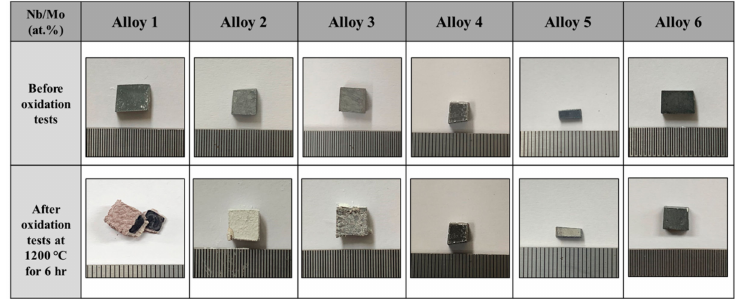
Figure 5. Images of Si-pack-coated specimens before and after oxidation tests at 1200 ◦ C for 6